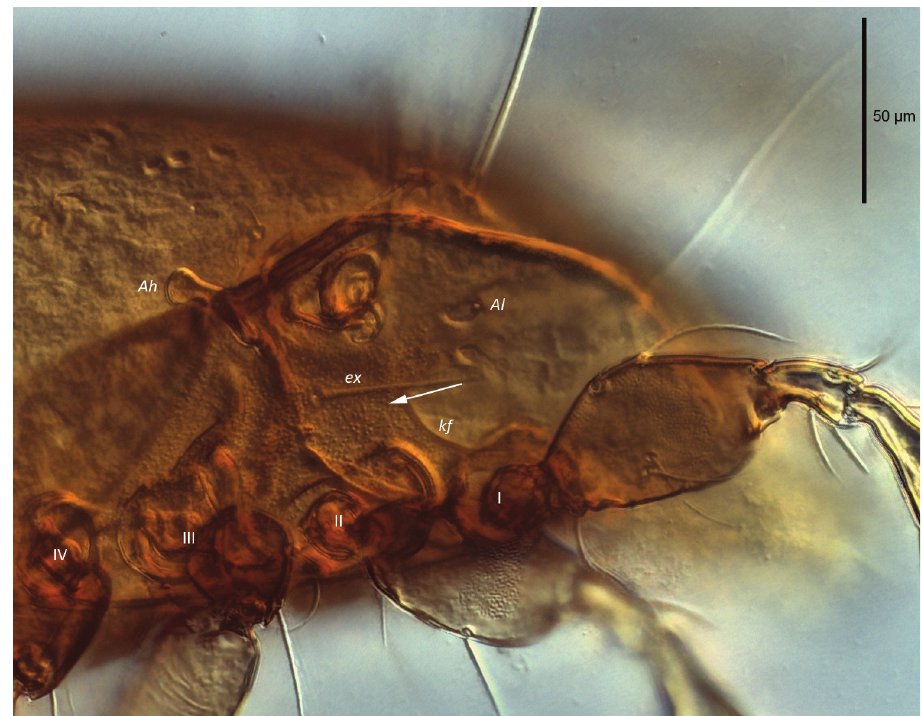
Figure 4. Female Paraleius leahae sp. n. photomicrograph of lateral view (DIC illumination), arrow indicating cuticular